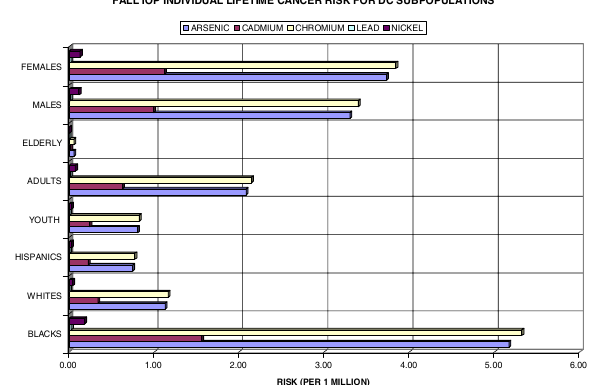
Figure 13: Fall IOP Lifetime Excess Lung Cancer Risk by DC Subpopulations